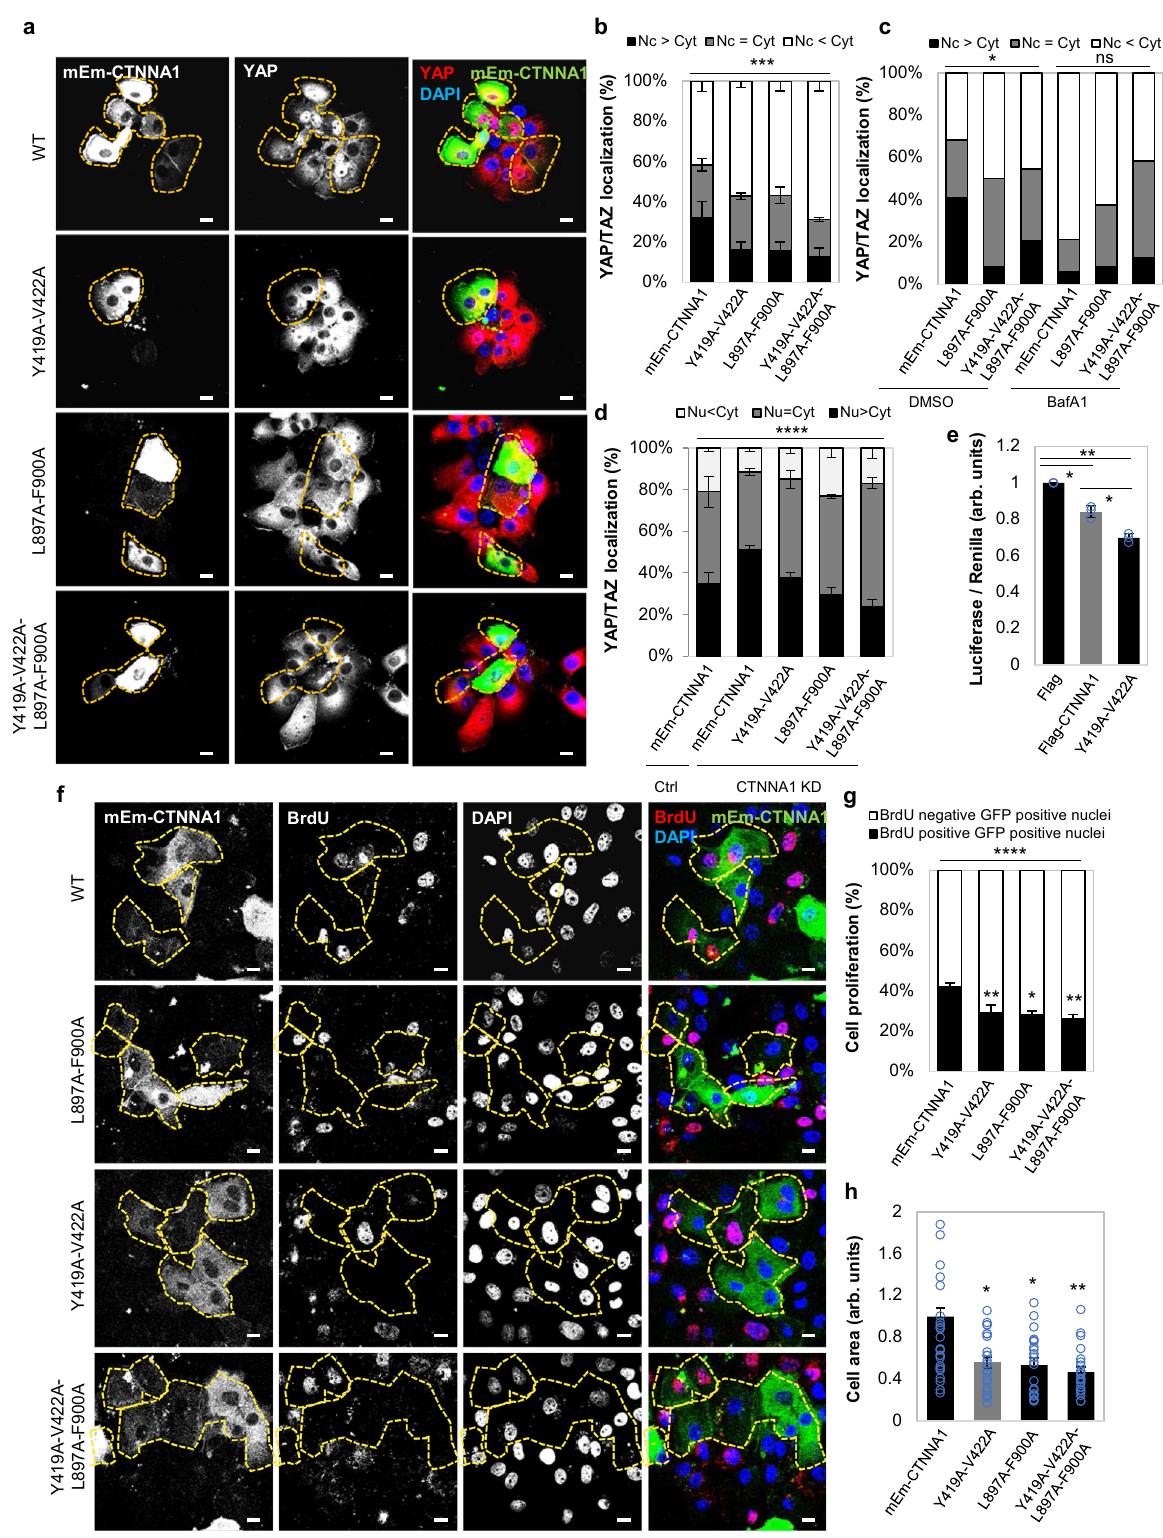
and homogenised 20 times with a 1 ml pipette. The viable neurons were pelleted by centrifugation, resuspended in culture medium and seeded on pre-coated plates. The medium was changed after 3 – 4h. Neurons were cultured in Neurobasal-A medium (12349-015, GIBCO Life technologies) supplemented with 200mM B27 (17504-044, GIBCO Life Technologies), 2 mM L -glutamine (G7513, Sigma- Aldrich) and 100 U/ml penicillin – streptomycin (P0781, Sigma-Aldrich) at 37°C and 5% CO 2 , humidi fi ed atmosphere. One half of the culture medium